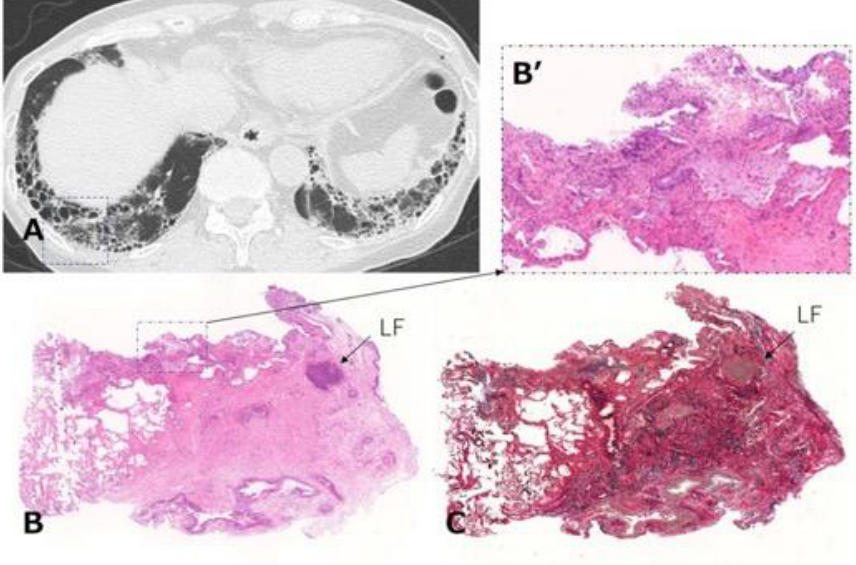
Figure 9. Transbronchial lung cryobiopsy in a case of RA-ILD (73-year-old woman). ( A ) Chest CT shows subpleural reticulations with honeycombing as the component of UIP in the lower lung. Lung cryobiopsy was performed in the right B9 (dashed square). ( B ) Hematoxylin and eosin staining show the lesion to be characterized by dense collagenous fibrosis with architectural destruction as a UIP pattern along with inflammatory cells including LF in the interstitial tissue. ( B’ ) A high-power magni- fication view of the dashed square in ( B ) shows a mild inflammatory change. ( C ) Elastica van Gieson staining shows the lesion as in ( B ). Abbreviations: RA = rheumatoid arthritis; ILD = interstitial lung disease; CT = computed tomography; UIP = usual interstitial pneumonia; LF = lymphoid follicle.